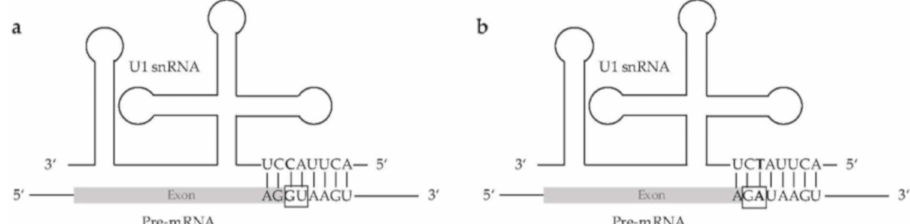
Figure 5. Hypothetical binding of the U1 snRNA to the pre-mRNA. ( a ) Binding sequence of the canonical U1 snRNA to the canonical 5 (cid:48) splice site GU (GT on DNA). ( b ) Hypothetical binding sequence of the non-canonical U1 snRNA (C > T) to the non-canonical 5 (cid:48) splice site